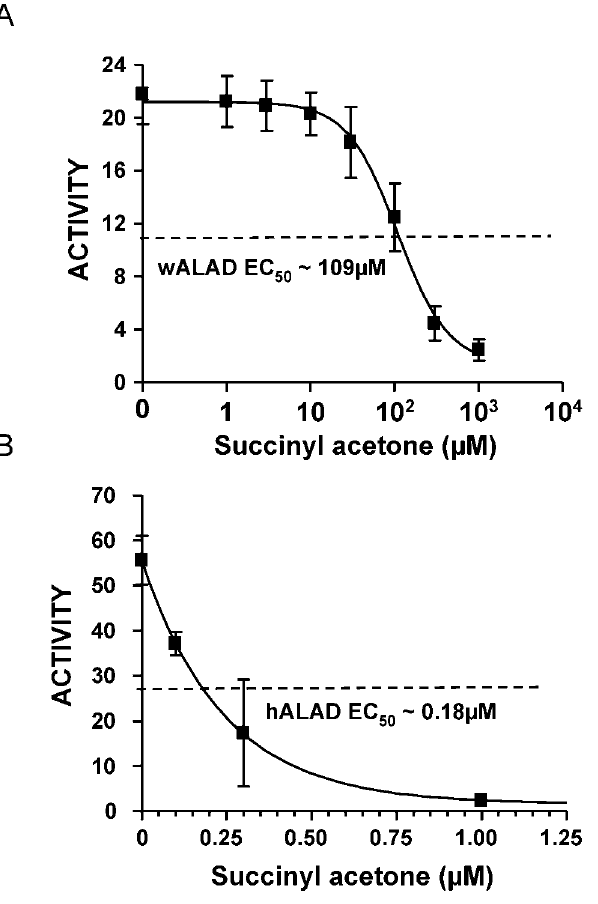
Figure 7. Biochemical characterization of recombinant wALAD and hALAD enzymes. A) Inhibition of wALAD enzyme activity by SA, B) Inhibition of hALAD enzyme activity by SA. The enzyme activity is expressed as m mol PBG/mg of protein/h.